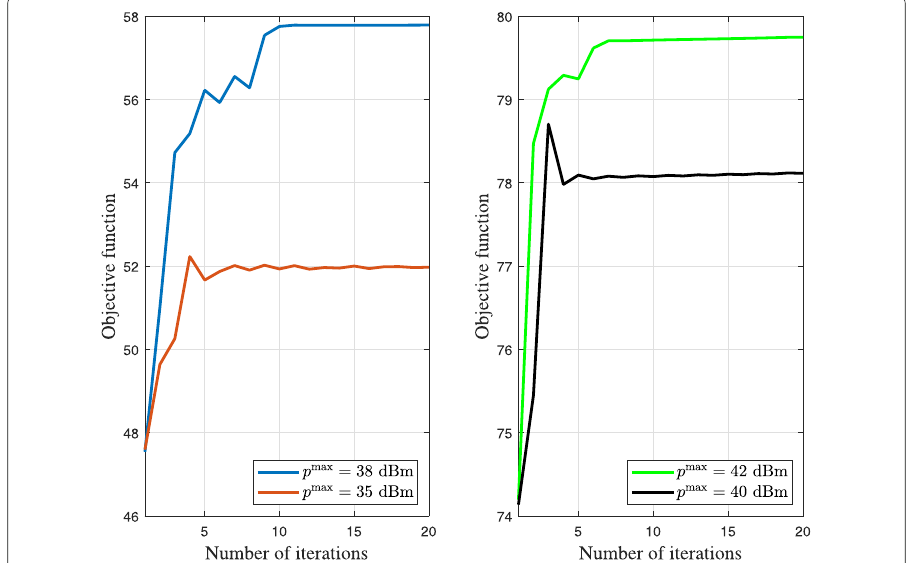
Fig. 4 The convergence behavior analysis of Algorithm 2 under the different maximum transmit power of